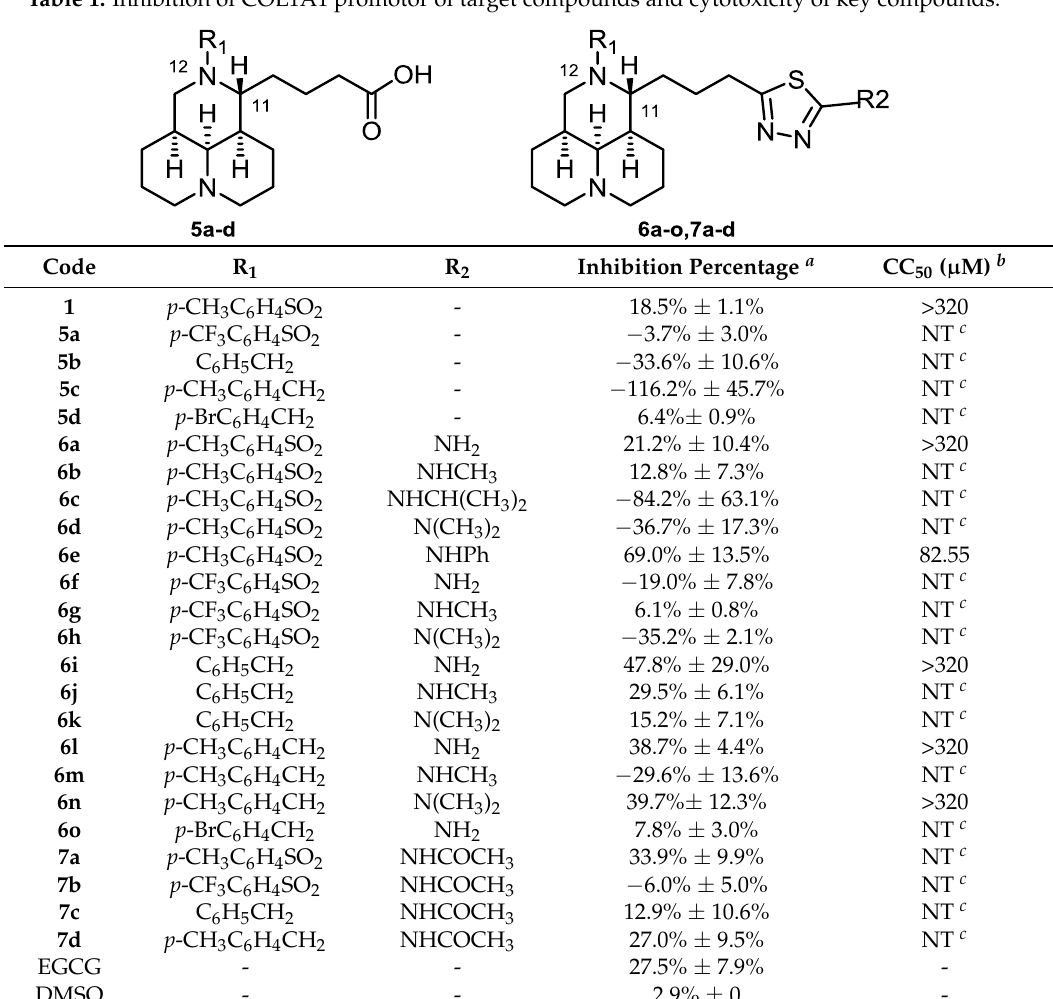
Table 1. Inhibition of COL1A1 promotor of target compounds and cytotoxicity of key